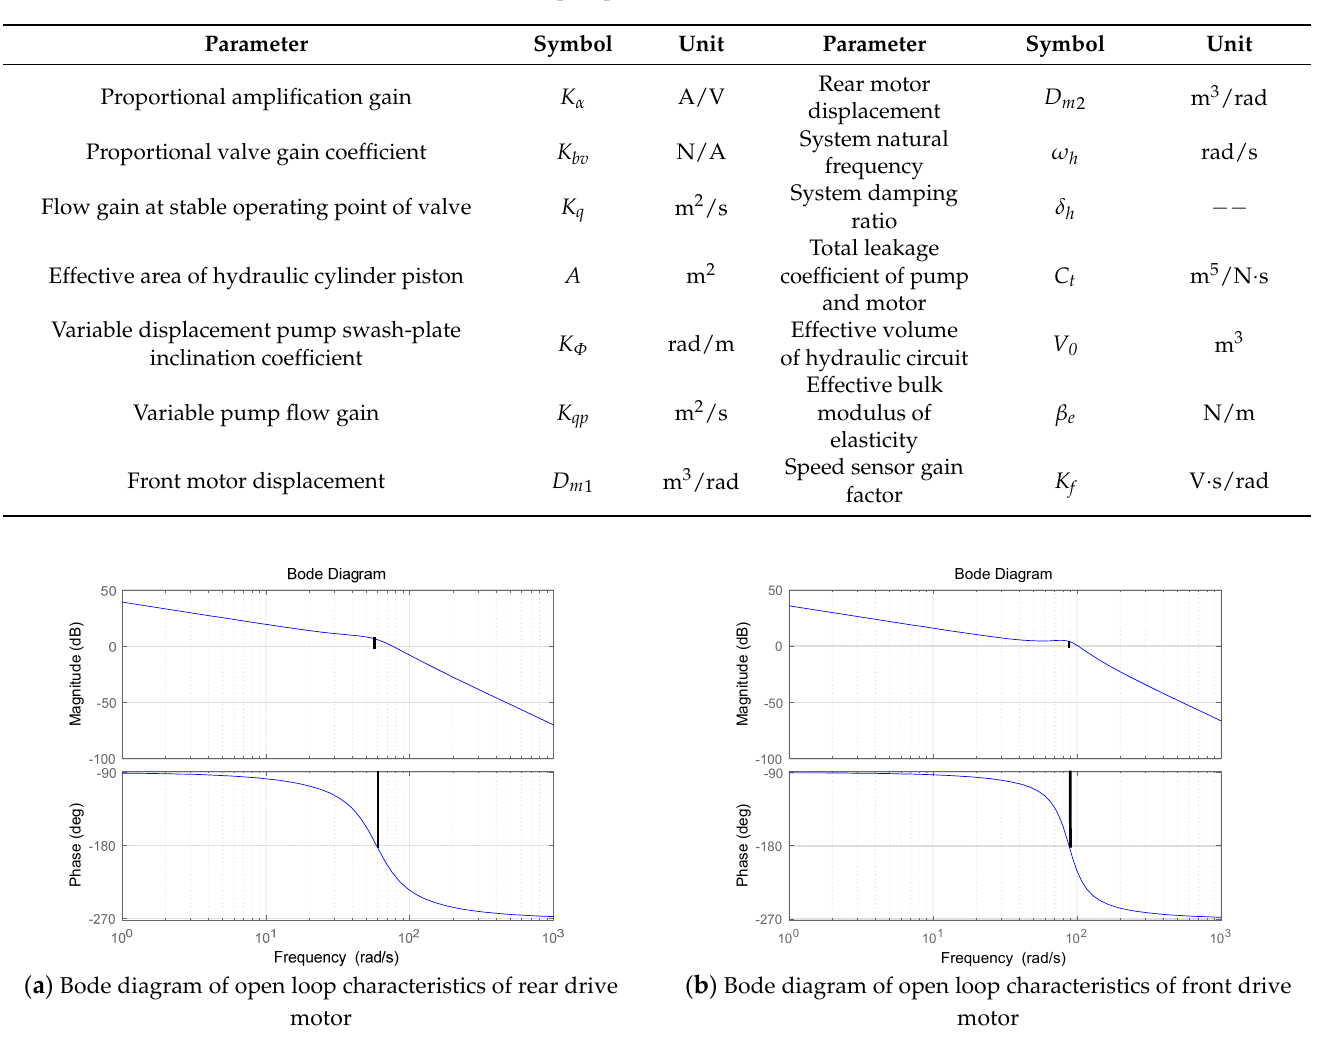
Figure 4. Bode diagram of the open-loop frequency characteristics of the system.